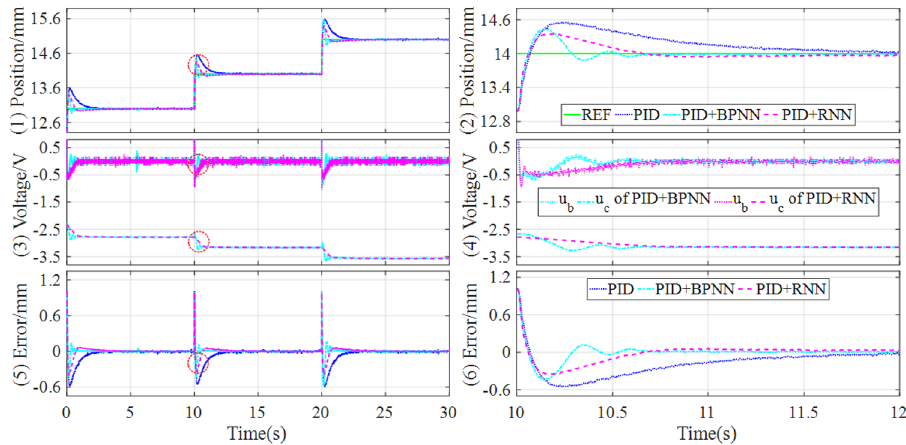
Figure 11. Experimental results of tracking continuous step signal under the different controllers.